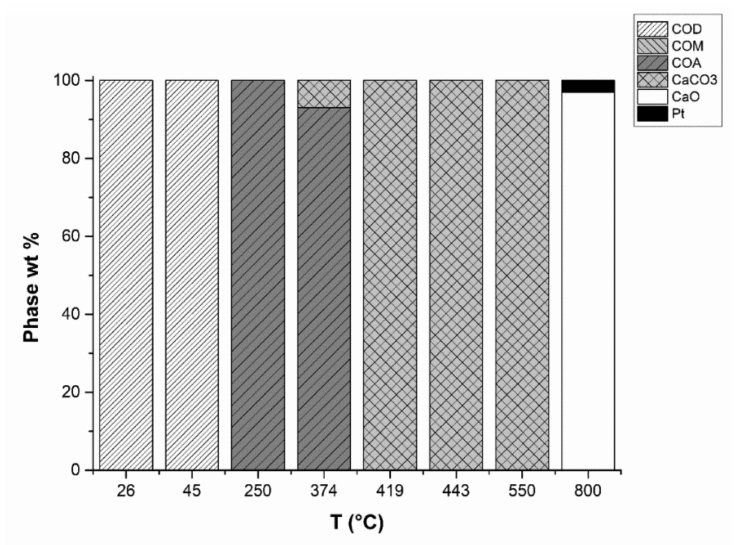
Figure 1. Ramp#1: The transitions between crystal phases are not well distinguished. Weddellite to whewellite transition is missing, as the anhydrous phase abruptly appears at 250 ◦ C. The same applies for CaO, which suddenly crystallizes at 800 ◦ C. Pt signal comes from the sample